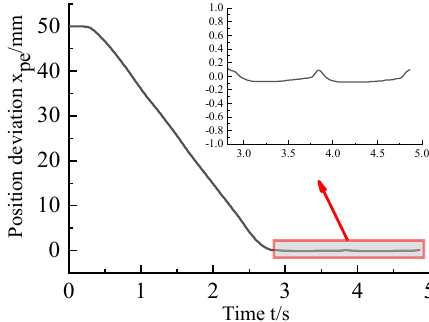
Figure 20. Error curve of step position.